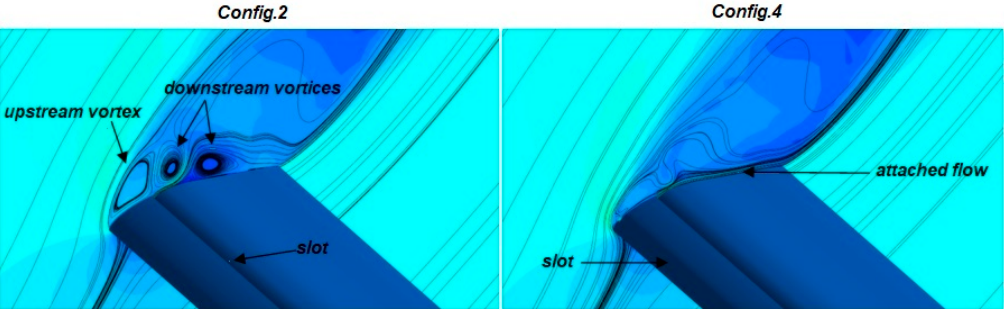
Figure 15. Streamlines and velocity distributions for configurations 1 to 4 compared to baseline at r/R